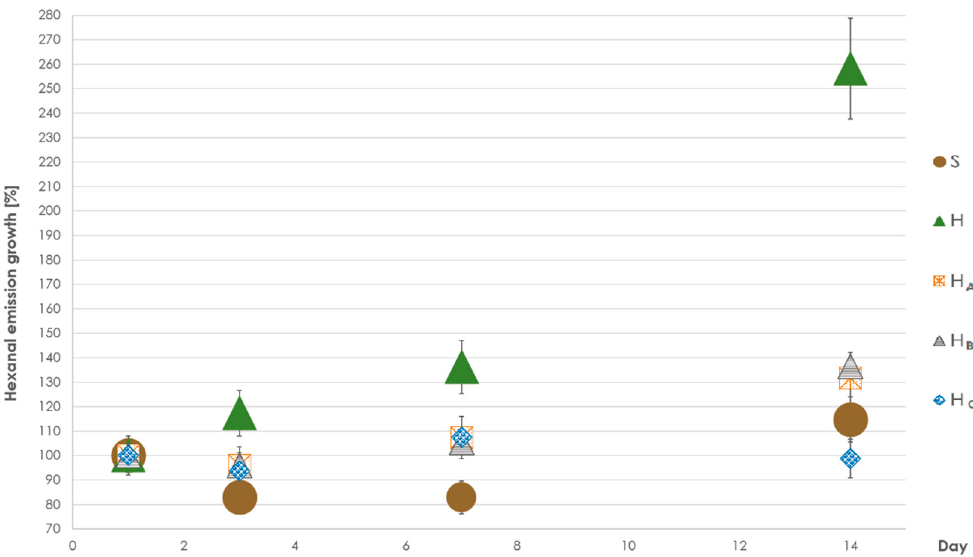
Figure 3. Hexanal emission changes (in %) in tested materials after storage in desiccators (day 1, 3, 7, 14); unique mass intensities first sampling day were considered as 100%. Error bars represent twice relative standard deviation of hexanal intensity measurement in 7 tested samples (8%). (S—spruce strands, H—untreated hemp shive, H A —hemp shive after tartaric acid treatment, H B —hemp shive